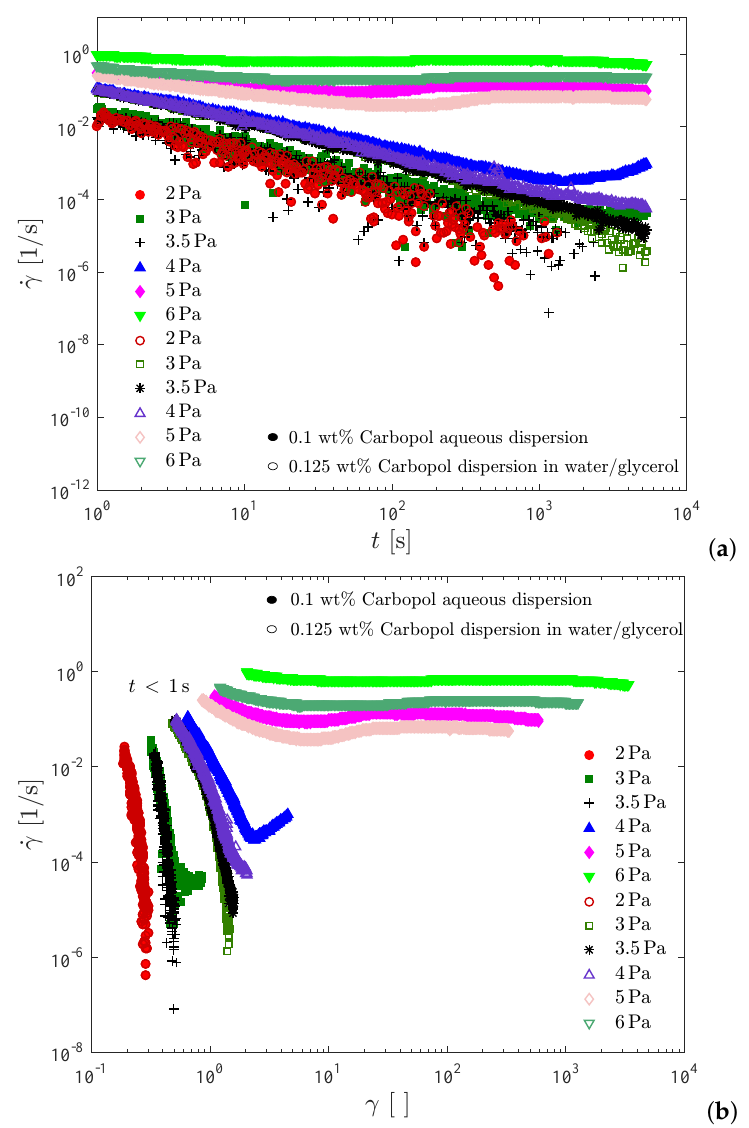
Figure 8. The creep tests. ( a ) Shear rate vs. time; ( b ) Shear rate vs.